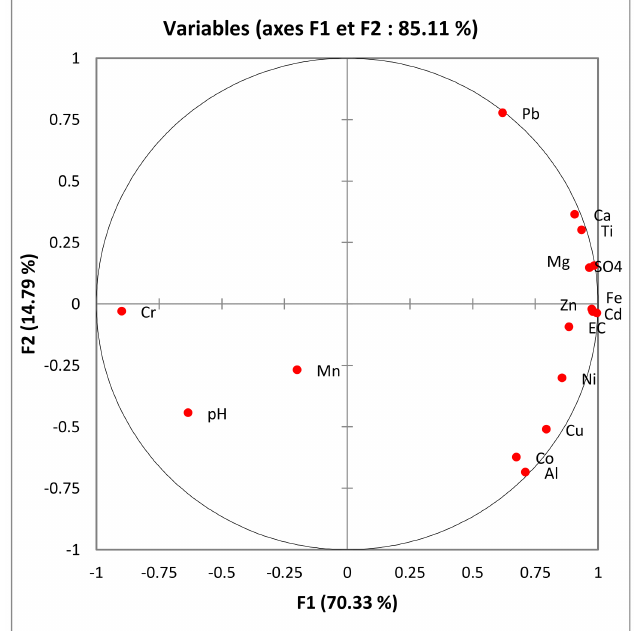
Figure 11. Principal component analysis for water sampled during the tenth campaign: projection of variables on the plane